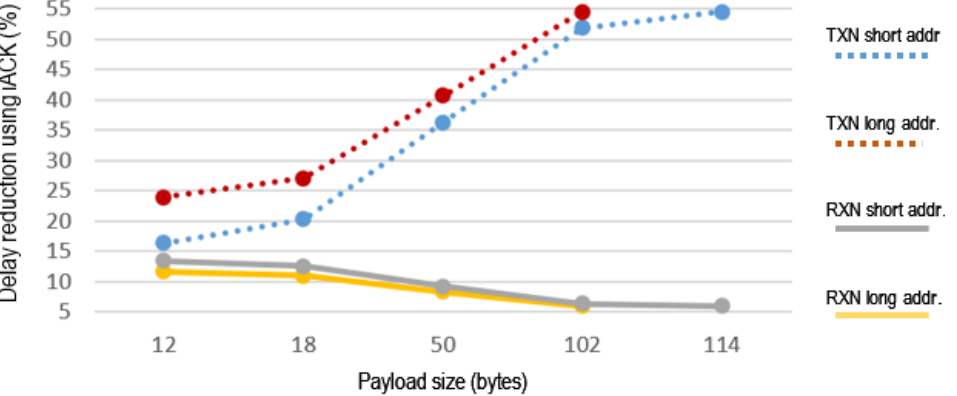
Figure 14. Delay reduction when using iACK compared to eACK.